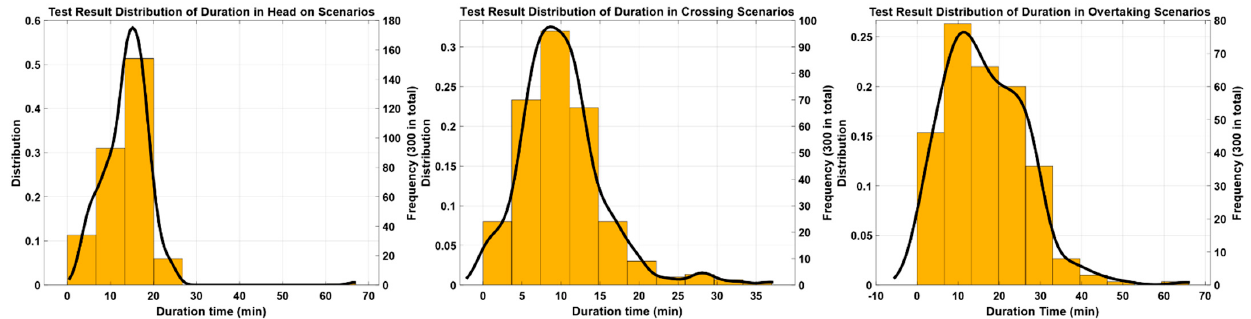
Figure 17. The distribution of the total duration of encounters by testing results.